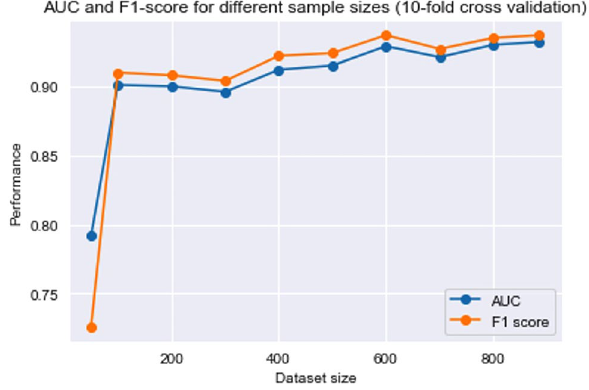
Figure 3. The performance of 24-symptom AdaBoost model when trained on different dataset